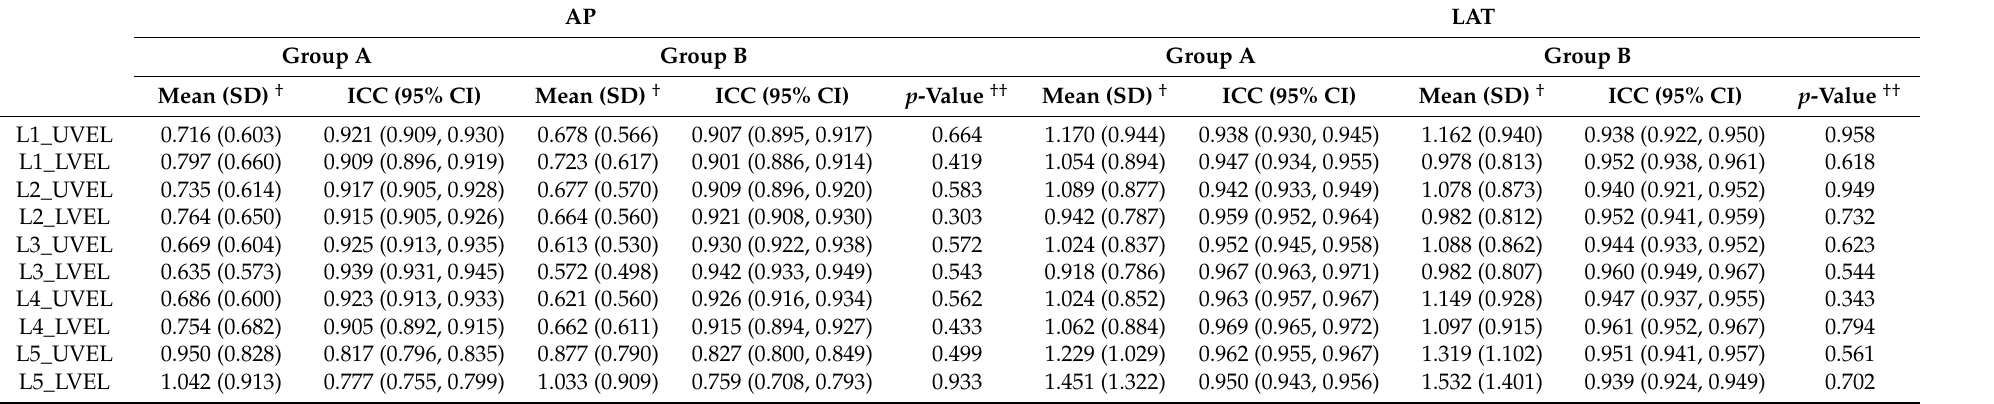
Table 3. Mean variations and inter-rater reliability of the angles of the UVEL and LVEL according to rater group. AP LAT Group A Group B Group A Group